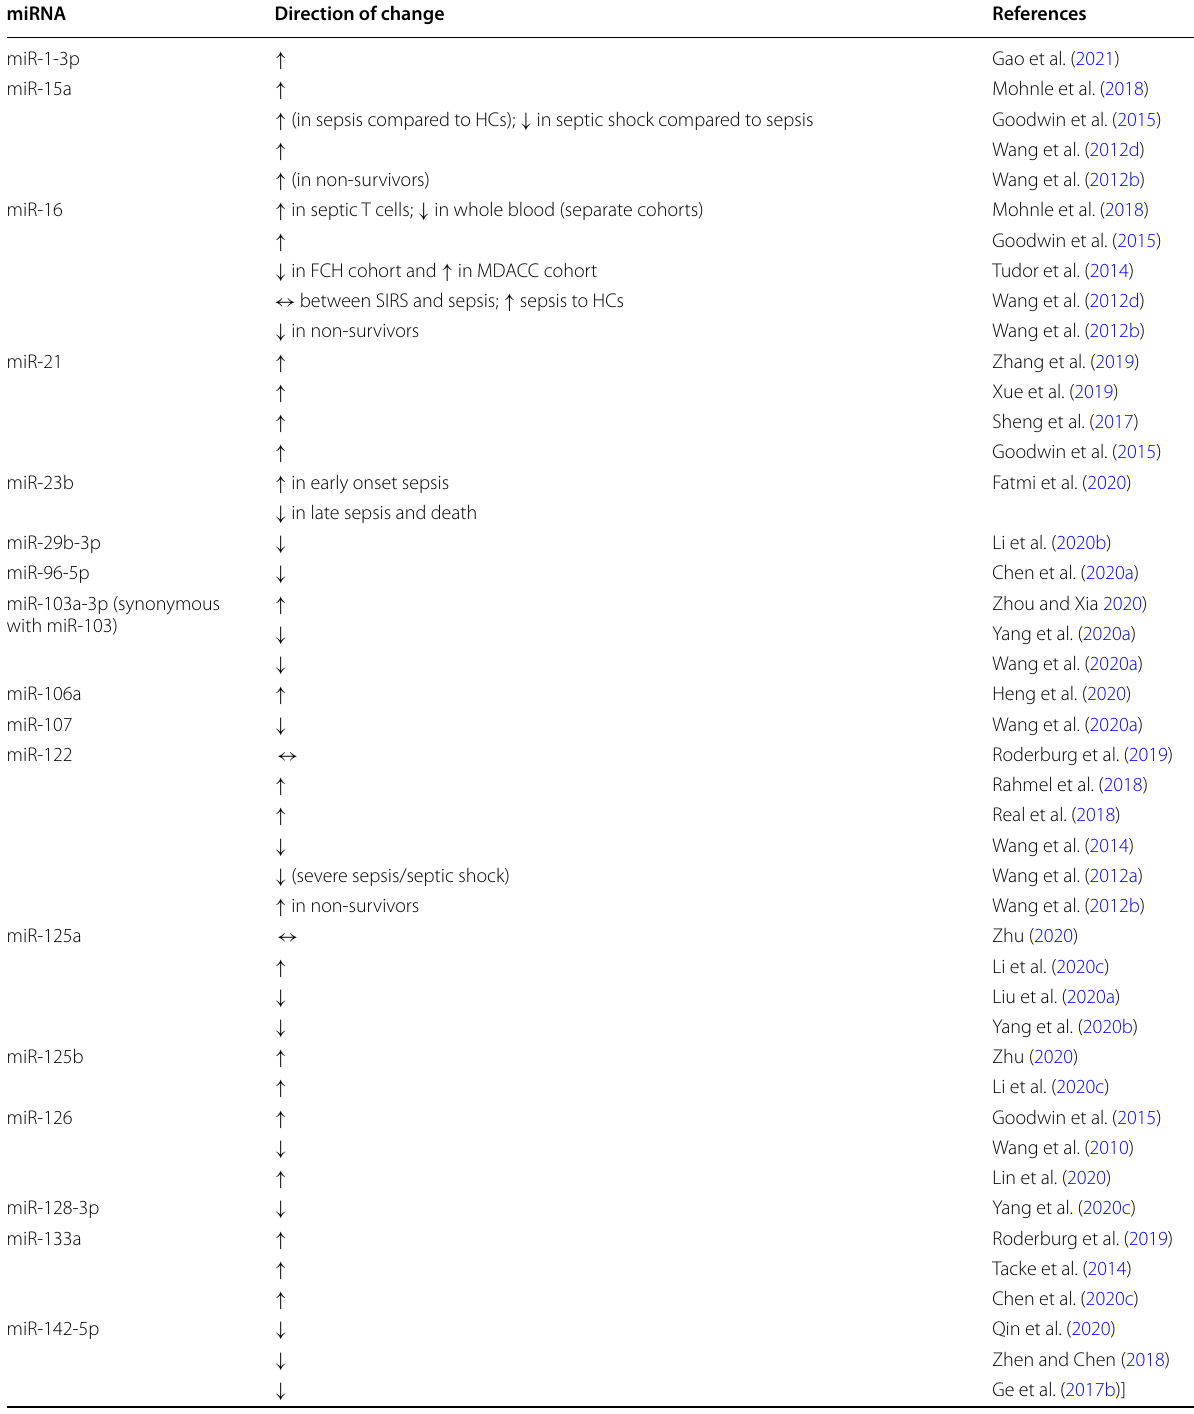
Table 1 Direction of fold change of miRNAs in human peripheral blood that are implicated in sepsis (in order of increasing miRNA) miRNA Direction of